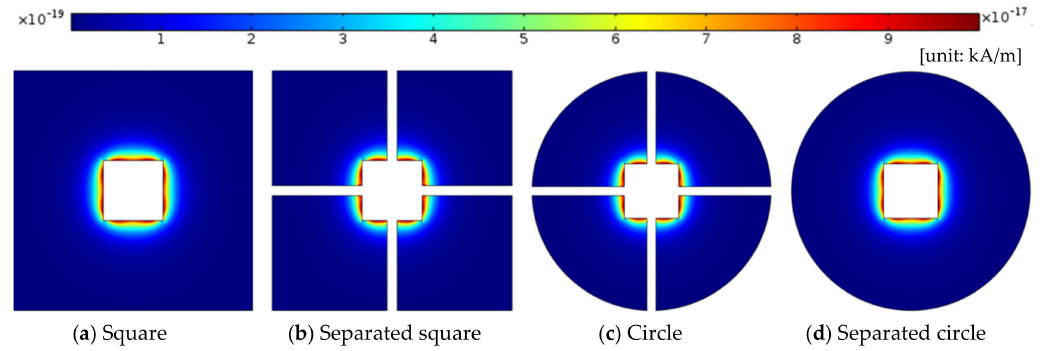
Figure 4. Magnetophoretic force distribution with the same magnetic field strength, H = 3000 (kA /